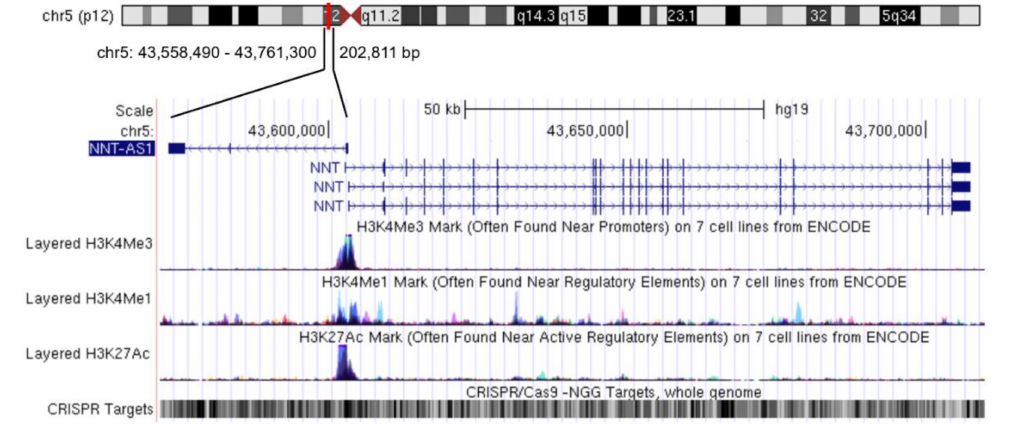
Figure 1. Genome position of long non-coding RNA (lncRNA) nicotinamide nucleotide transhydrogenase-antisense 1 (NNT-AS1). NNT-AS1 is mapped to chromosome 5. Reference information comes from the University of California Santa Cruz (UCSC) Genome Browser (http: // genome.ucsc.edu /